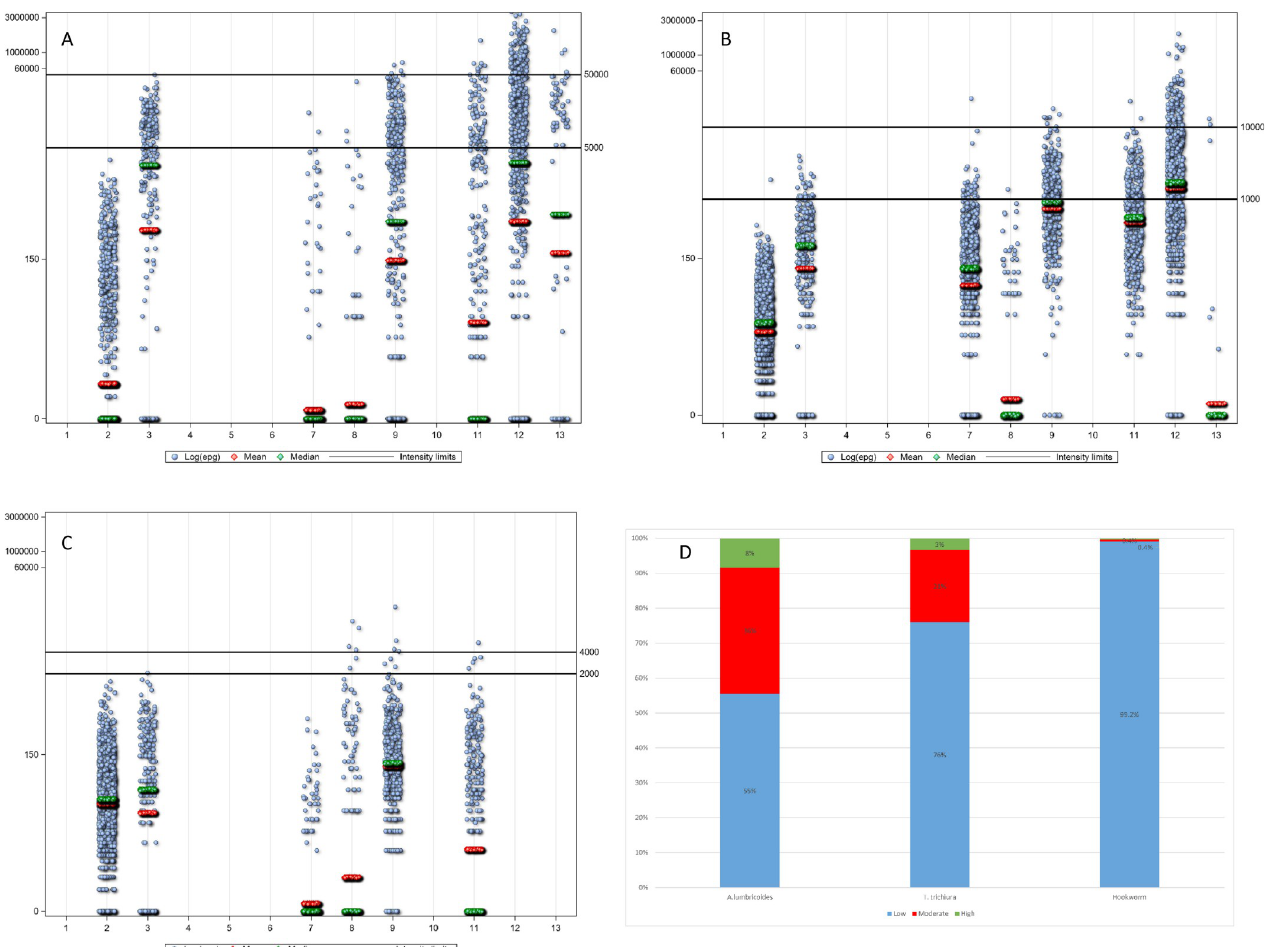
Fig 2. Distribution of raw egg counts (eggs per gram of feces) at baseline by study. A. Ascaris lumbricoides , B. Trichuris trichiura , C. hookworm, D. baseline intensity of infection by species ([37], page 33, Table 7 of the referenced